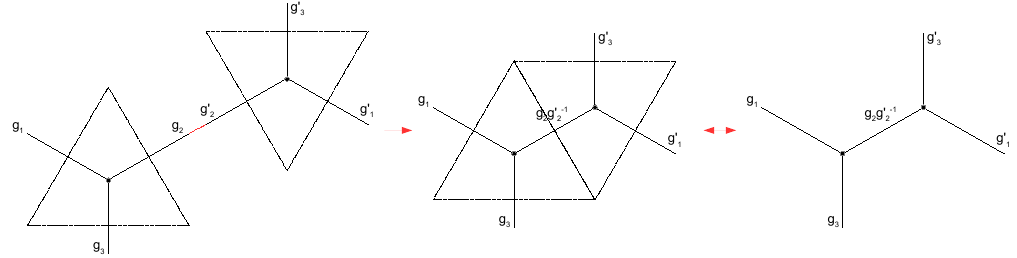
Figure 2 . Example of the gluing of two “quanta of space” of the GFT model with d = 3 , which are triangles dual to trivalent vertices. The quanta are glued along the face/open-link of colour 2 . The resulting link carries the group variable g g’ − 1 given by the product of the original open-link 2 2 variables g and g’ 2 2